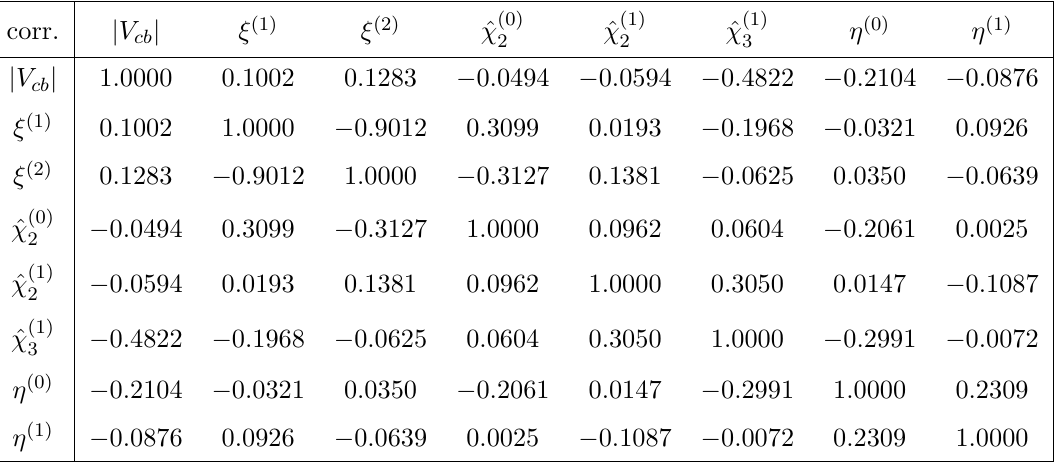
n (cid:24) ( n ) ; ^ (cid:31) ( n )